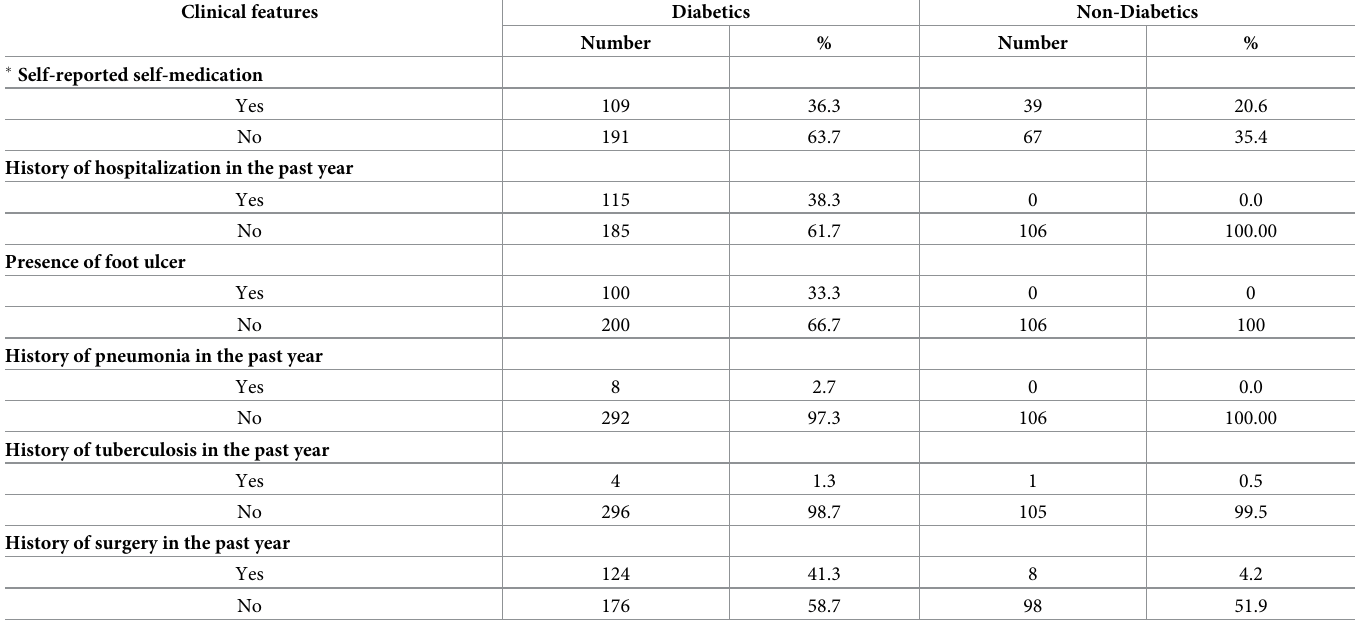
Table 2. Clinical features of the study participants. Clinical features